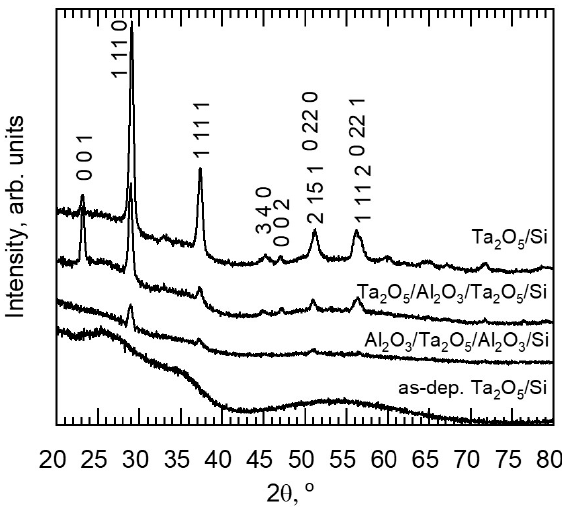
Figure 7. SPM images of the surface of laminates after annealing at 800 ◦ C: ( a ) Ta 2 O 5 /Si; ( b ) Ta 2 O 5 /Al 2 O 3 /Si. Images depict plastic deformation marks left in the material by the trian- gular pyramid-shaped Berkovich tip during nanoindentation.